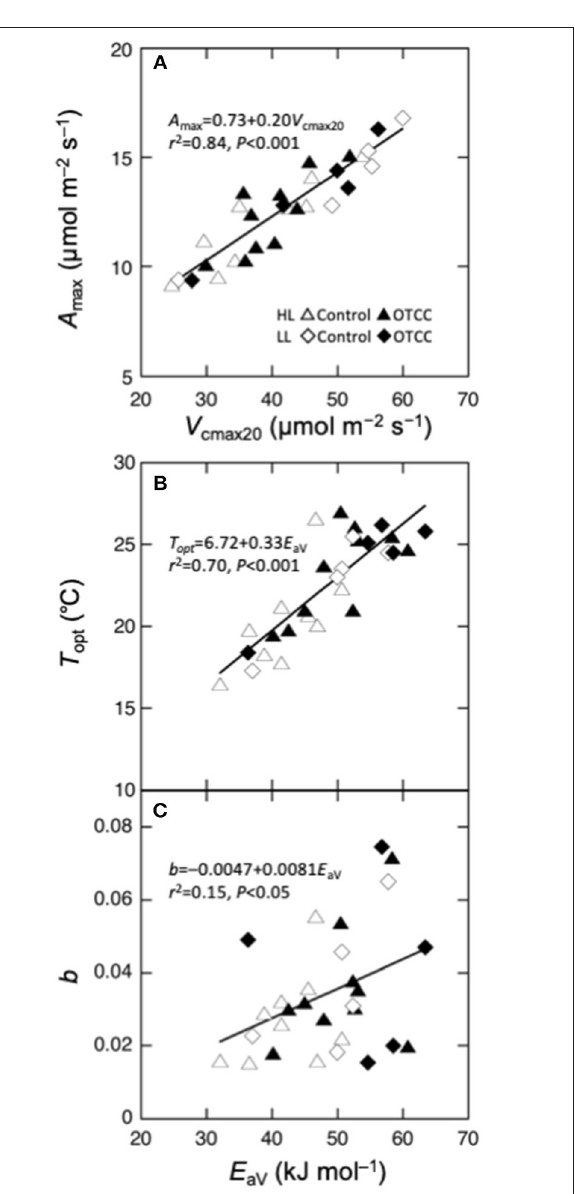
FIGURE 5 | Parameters of temperature dependence of photosynthesis as a function of biochemical parameters. (A) Maximal photosynthetic rate ( A max ) at the optimal temperature vs. the maximal carboxylation rate at 20 ◦ C ( V cmax20 ), (B) optimal temperature that maximizes photosynthetic rate ( T opt ) vs. activation energy of apparent V cmax ( E aV ); (C) spread of temperature response parabola ( b ) vs. E aV . Curvilinear is the linear regression for all data points.